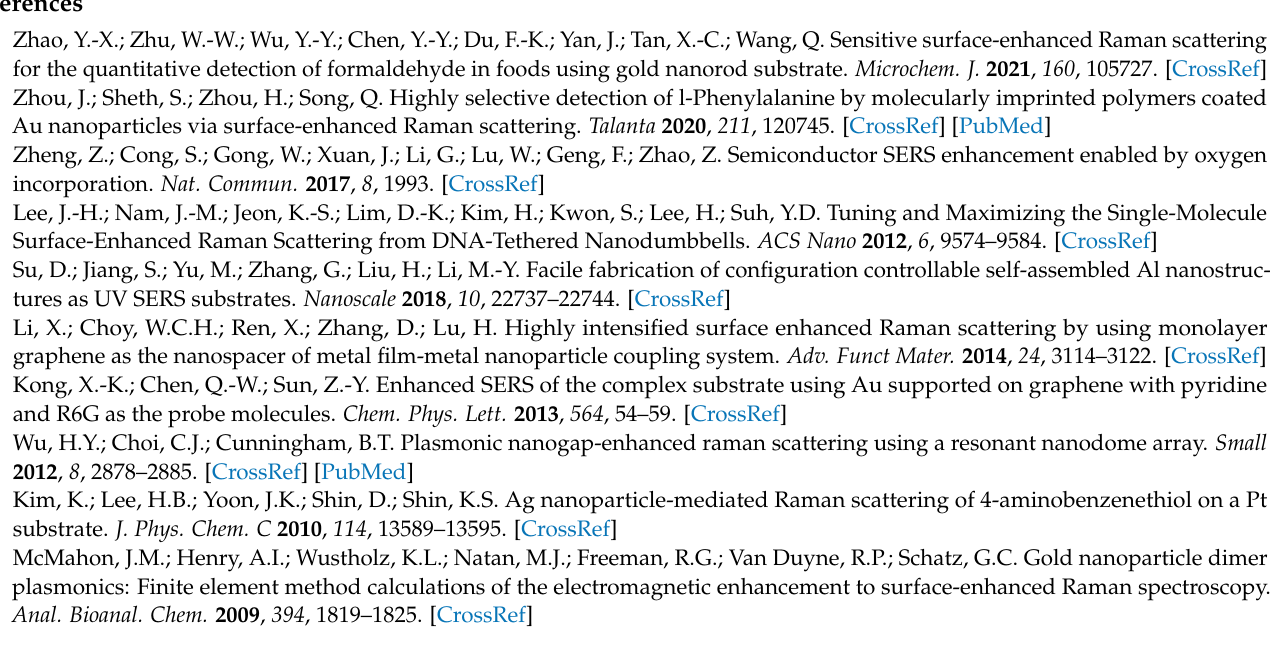
Figure S2: SERS spectra of 4-Mpy on Nd-TiO 2 NPs substrate (blue line) and in bulk condition (green